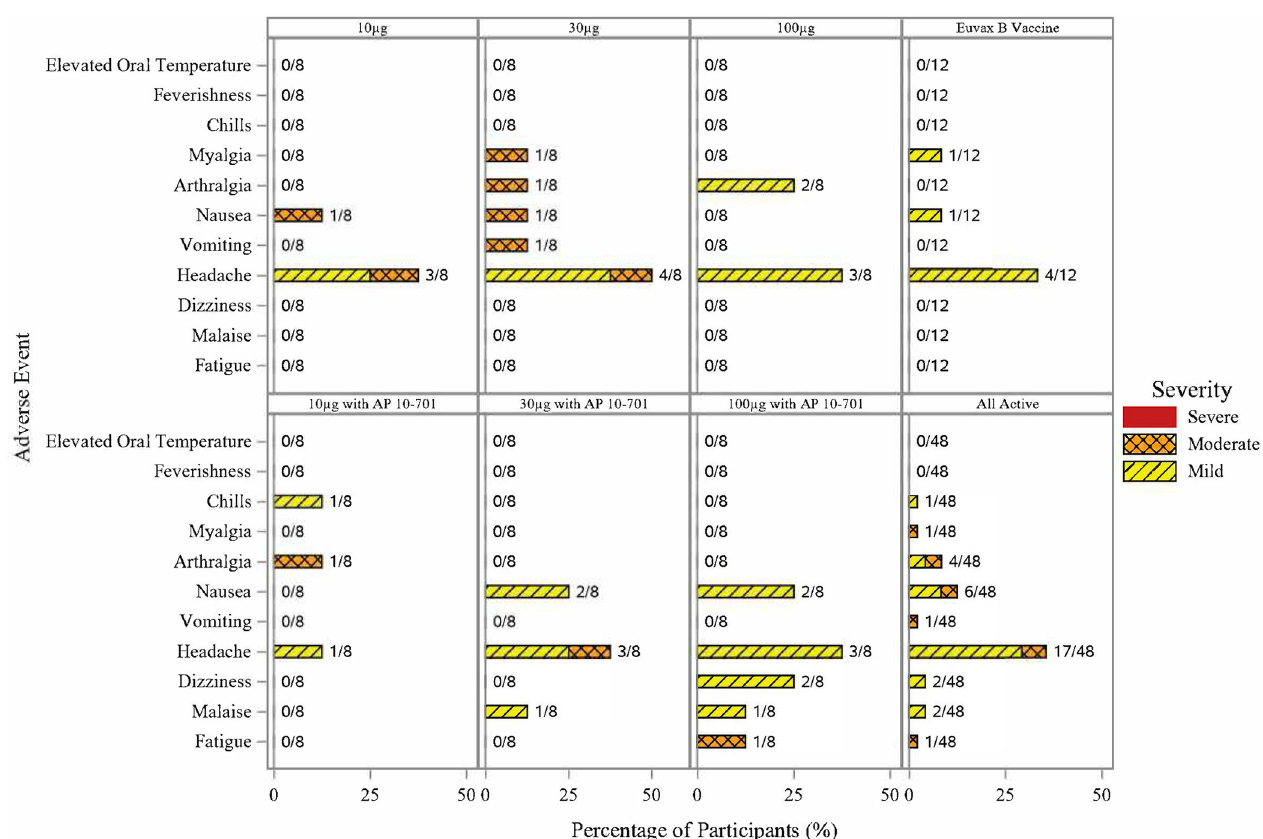
Fig 3. Number and percentage of participants experiencing solicited systemic events after any dose of vaccine by event, maximum severity, and vaccine group.